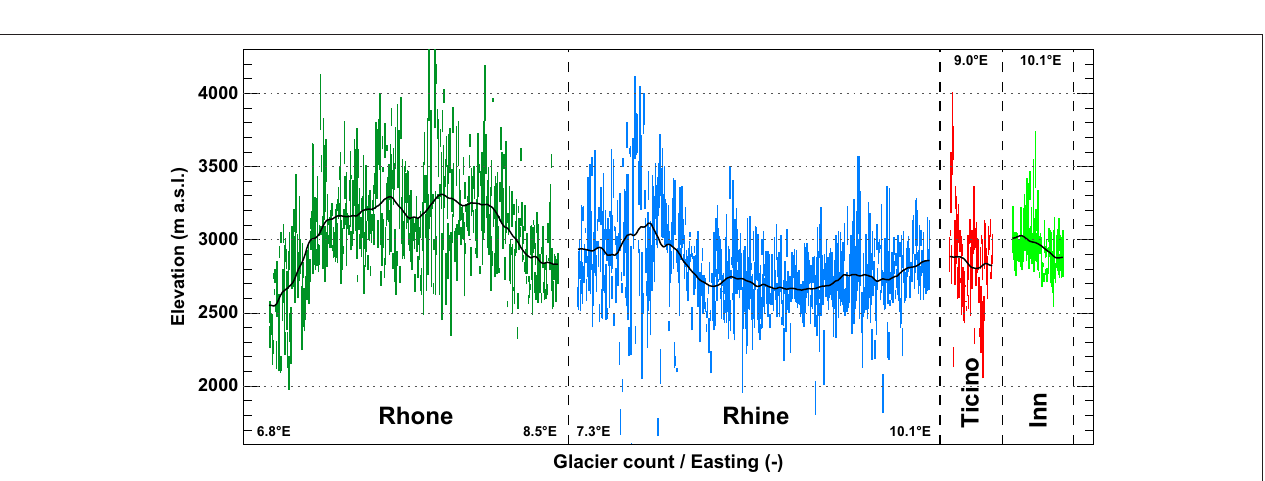
glacier based on aerial imagery. About one third of all very small glaciers presently exhibits some debris coverage but the regional variations are considerable ( Figure 1 ) and are likely related to different geological and topographical boundary